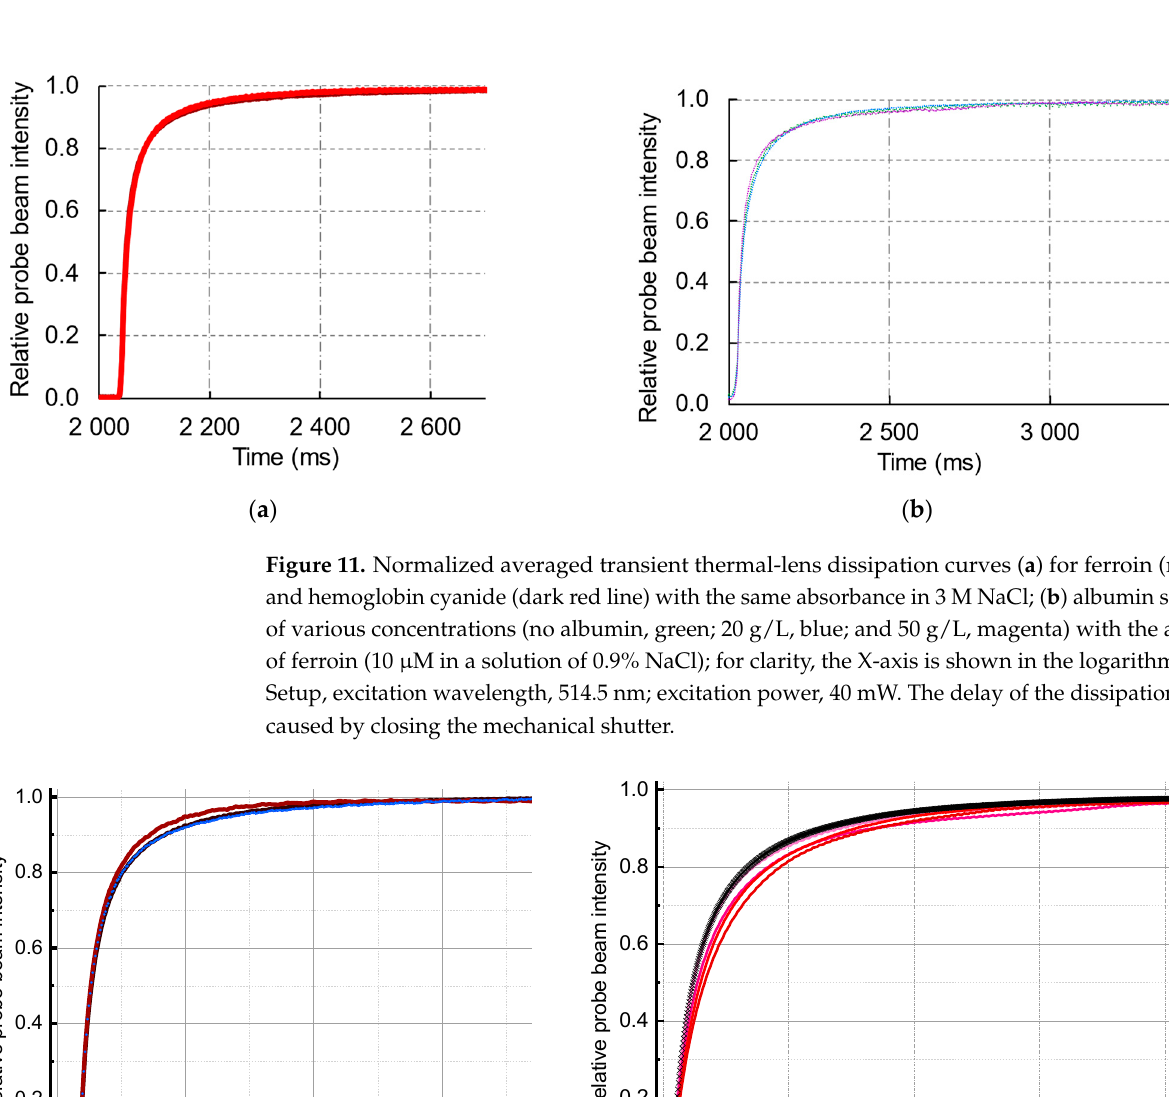
Figure 10. Normalized averaged transient thermal-lens curves for the heating stage. ( a ) For water, light blue symbols, and aqueous colloidal solutions of TM-50 silicon oxide (1.6 and 3.1% v / v , black and red lines, respectively). The higher the nanoparticle concentration, the faster the heating of the solution. ( b ) For aqueous dispersions of RUDDM nanodiamonds at concentrations of 1, 1.5, 2, and 2.5 mg/mL (light pink, pink, red, and burgundy lines, respectively) and for water (black symbols). Heating time, 4 s. Setup, TLS-60; excitation wavelength, 532.0 nm; excitation power, 20 mW. The higher the nanoparticle concentration, the faster the heating of the solution. The cooling (dissipation) curves of the thermal-lens measurements were taken separately from the heating curves due to the different behavior of these curves, as the signal development is governed by a balance between the external source fluence and the